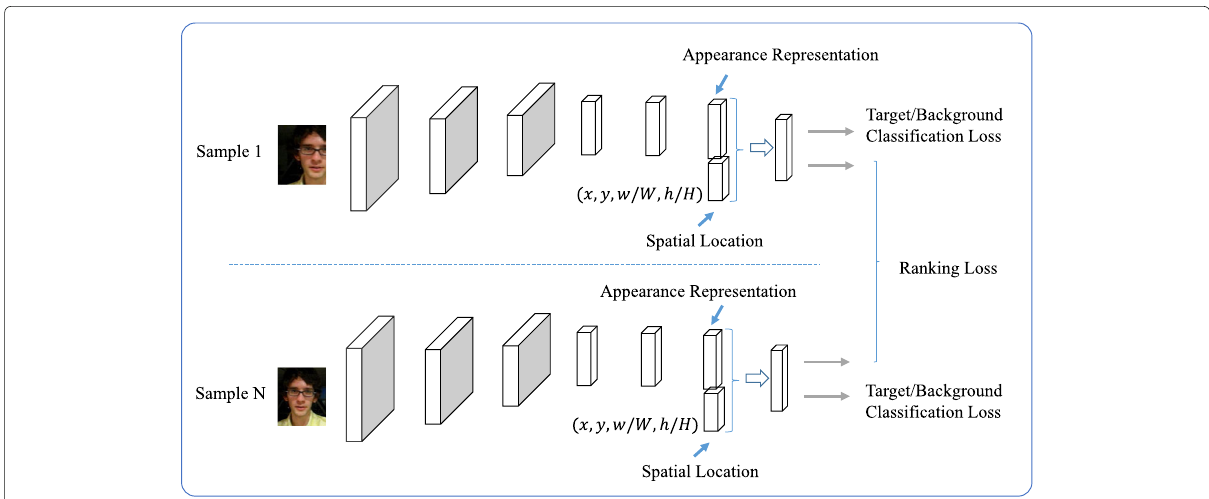
Fig. 3 The main architecture of the proposed neural network. In the training phase, it takes two image regions as input and output the target/background classification scores. Softmax loss and margin ranking loss are employed for training. In the test phase, only one branch is